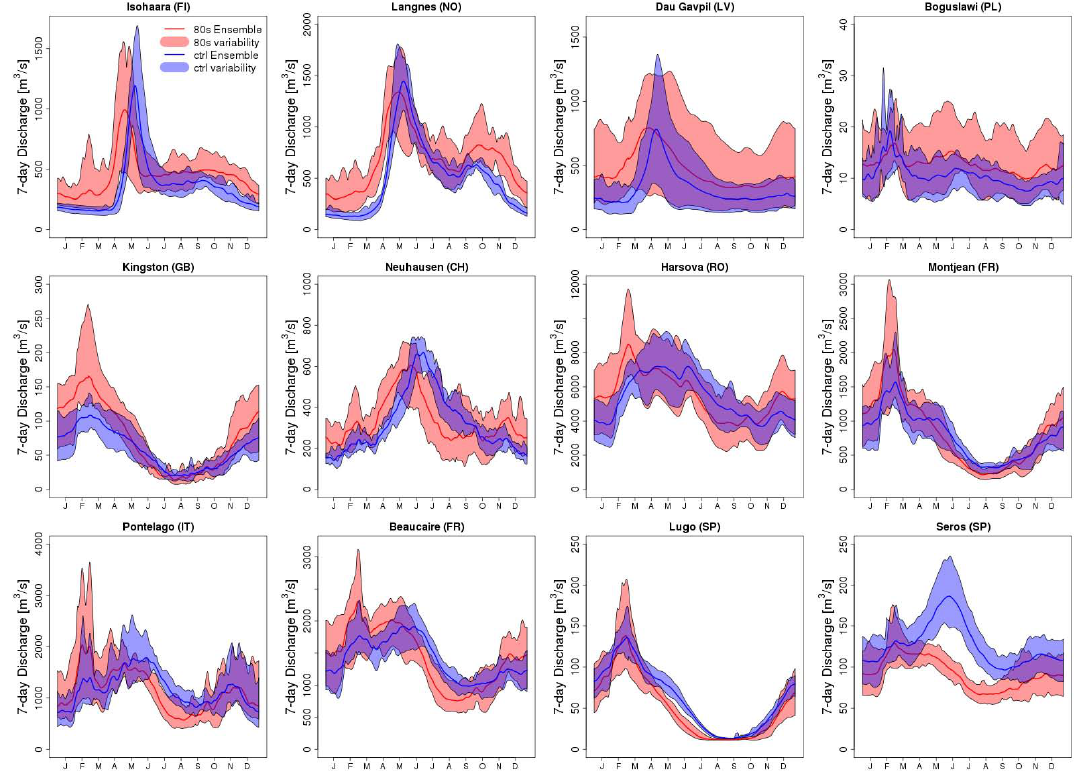
Fig. 12. Inter-annual dynamics in simulated 7 day streamflow for the control period and the 2080s for selected stations (see Fig. 1). The thin blue and red lines represent the ensemble averages for the control and 2080s, respectively. The corresponding shaded areas show the spread amongst ensemble members within the respective